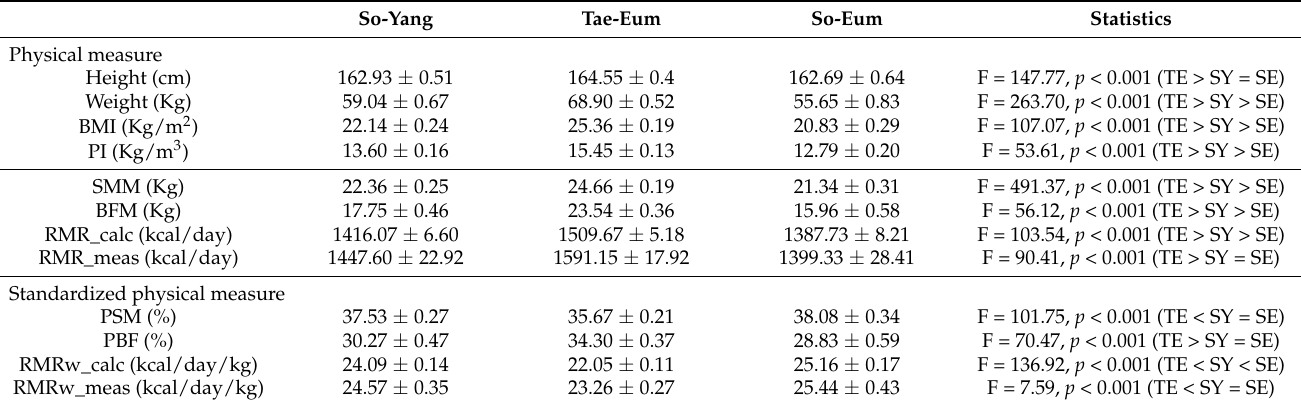
Table 3. Estimated physical characteristics of each Sasang type using analysis of covariance.